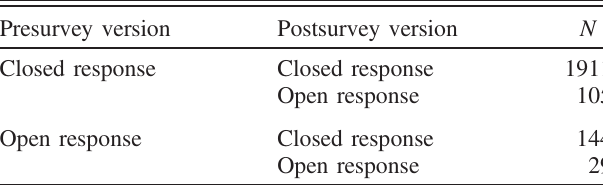
TABLE VI. Number of students in the matched dataset who took each version of the PLIC. The statistical analyses focus presurvey and closed-response